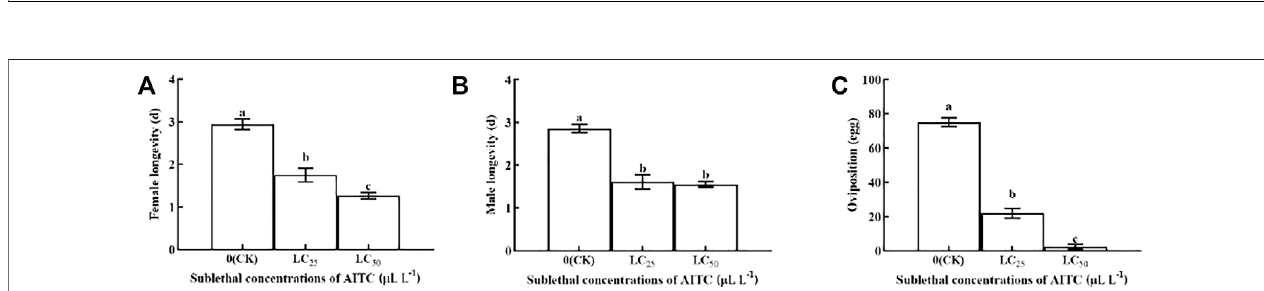
FIGURE3| Changesinthepupationrate (A) ,pupaweight (B), andadultemergencerate (C) of B.impatiens aftersub-lethalconcentrationfumigationofAITC.Data represent mean ± SD of three replicates. Different lower-case letters indicate statistically signi fi cant difference between sub-lethal concentrations by Tukey ’ s test ( p < 0.05).